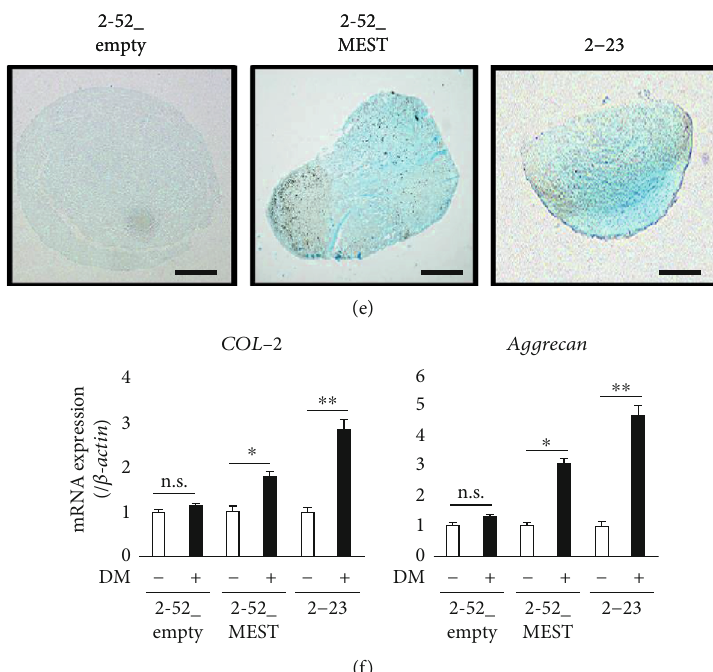
Figure 6: The e ff ects of MEST overexpression on the multidi ff erentiation capacity in 2-52 cells. (a) The formation of mineralized nodules in 2-52_empty or 2-52_MEST was examined by Alizarin red S staining after culture in osteogenic DM for 3 weeks (bars: 5mm). (b) The gene expression of ALP and Osterix in 2-52_empty or 2-52_MEST, which were cultured with or without DM for 3 days, was assessed by quantitative RT-PCR. (c) The lipid vacuoles in 2-52_empty or 2-52_MEST were examined by Oil red O staining after culture in adipogenic DM for 3 weeks (bars: 20 μ m). (d) The gene expression of PPAR γ and C/EBP α in 2-52_empty or 2-52_MEST, which were cultured with or without DM for 3 days, was assessed by quantitative RT-PCR. (e) The cartilaginous matrix in 2-52_empty or 2-52_MEST was examined by Alcian blue staining after culture in chondrogenic DM for 4 weeks (bars: 200 μ m). (f) The gene expression of COL-2 (k) and Aggrecan (l) in 2-52_empty or 2-52_MEST, which were cultured with or without DM for 3 days, was assessed by quantitative RT- PCR. All values are means ± S : D : (error bars) of quadruplicate assays ( n = 4 , ∗∗ p < 0 : 01 , ∗ p < 0 : 05 . n.s.: not signi fi